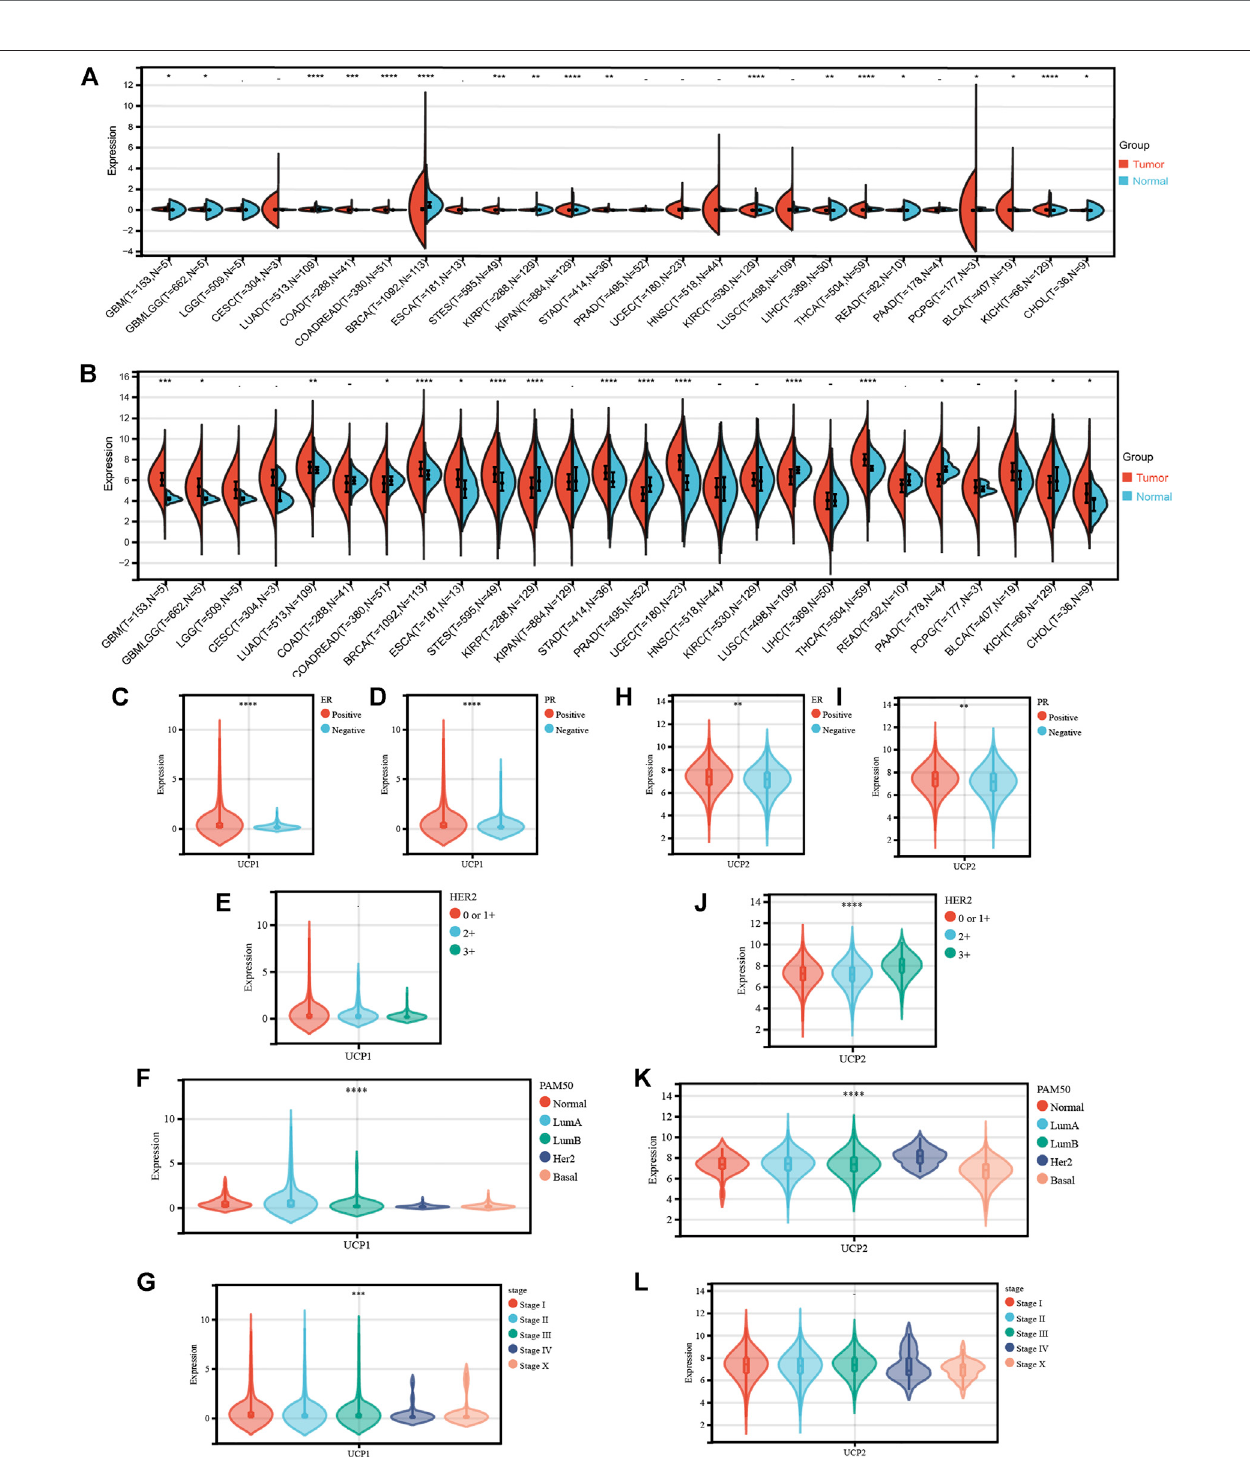
FIGURE1| Transcriptionalpro fi leofUCP1andUCP2inbreastcancer. (A) UCP1and (B) UCP2transcriptionalexpressionin34cancerspecimensascomparedto normal tissues from TCGA. (C – G) UCP1 transcriptional expression according to different (C) ER status, (D) PR status, (E) HER2 status, (F) PAM50 subtype, and (G) stage. (H-L) UCP2 transcriptional expression for different (H) ER status, (I) PR status, (J) HER2 status, (K) PAM50 subtype and (L) stage. The statistical difference was compared through the one-way ANOVA and student t-test. * p < 0.05; ** p < 0.01; *** p < 0.001; **** p < 0.0001.